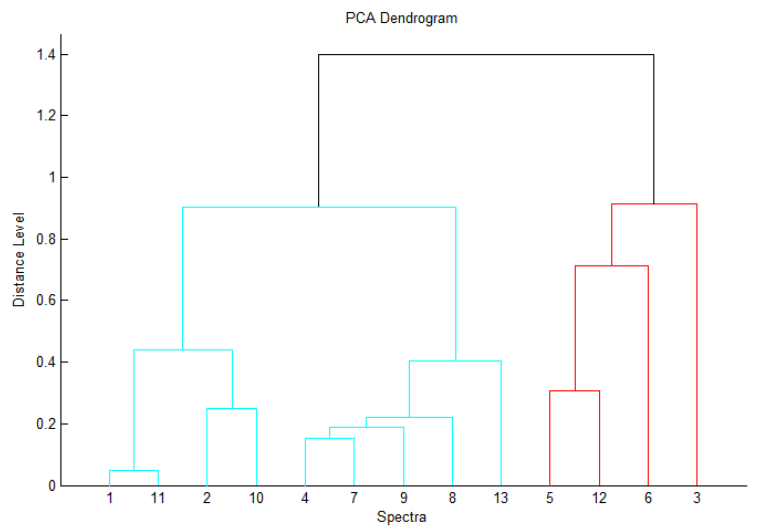
Figure 3. PCA-based dendrogram mass spectra of the tested E. coli isolates generated by MALDI-TOF MS. Non-related isolates are illustrated by red.